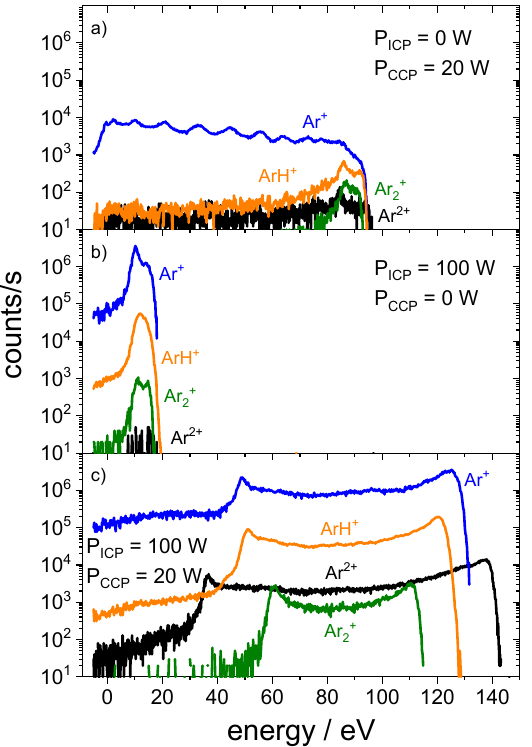
Figure 6. IEDFs of argon-related ions in an argon plasma at 5 Pa. ( a ) Only capacitive power coupling to the reactor wall with a power of 20 W. ( b ) Only inductive coupling with a power of 100 W applied to the planar rf coil. ( c ) Both inductive and capacitive couplings are